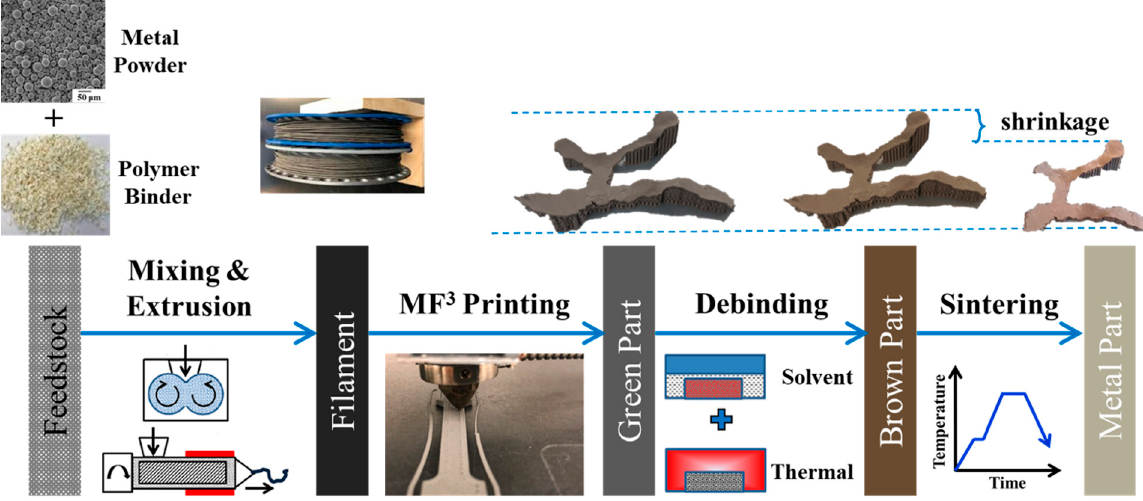
Figure 1. Overview of MF 3 process showing filament preparation, 3D printing, debinding and sintering, and demonstration of an implant prototype fabricated by MF 3 with Ti-6Al-4V alloy.